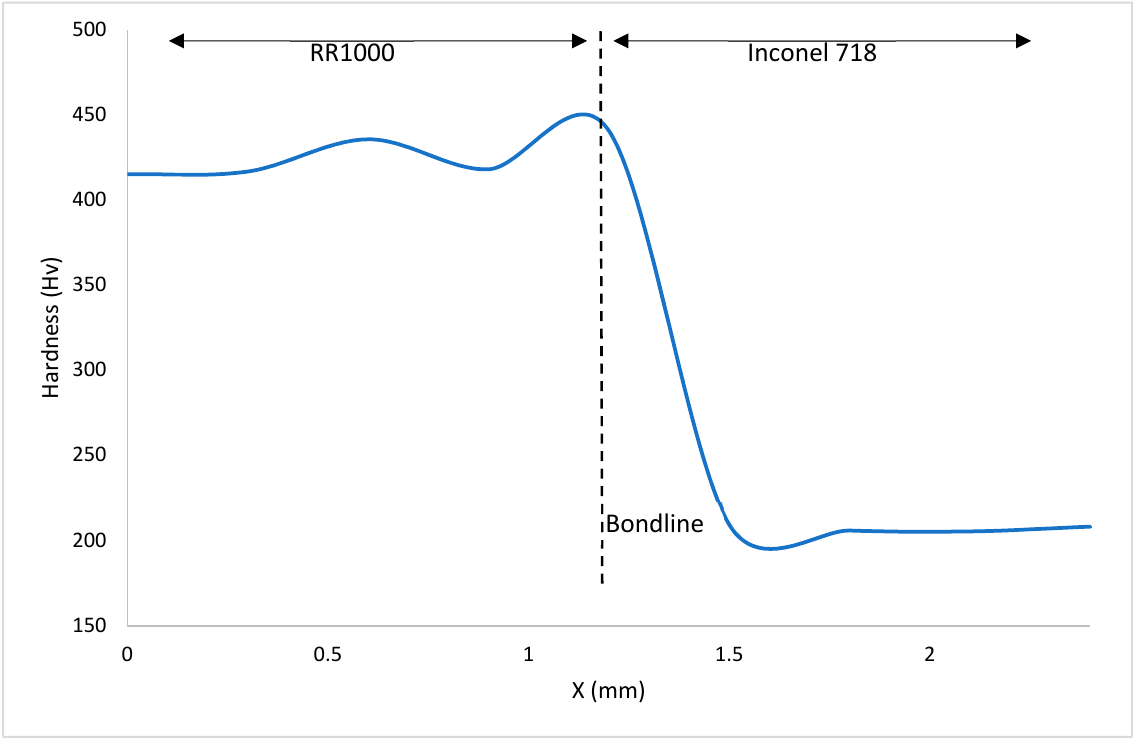
Figure 11. Graph detailing Vickers Hardness variation in bond 3. For all the bonds there is a decrease in hardness as the distance from the bondline and HAZ is increased. Similar trends to this have been observed in inertia friction